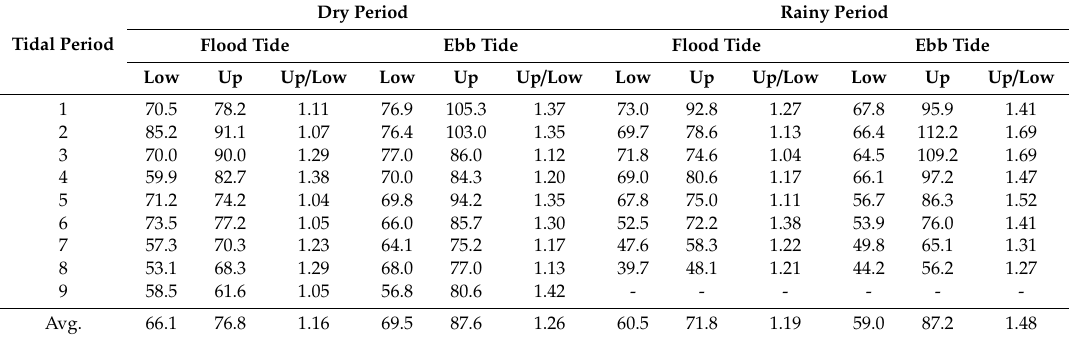
Table 1. Comparison of the ratio of the averaged upper flow velocity to the averaged lower flow velocity.